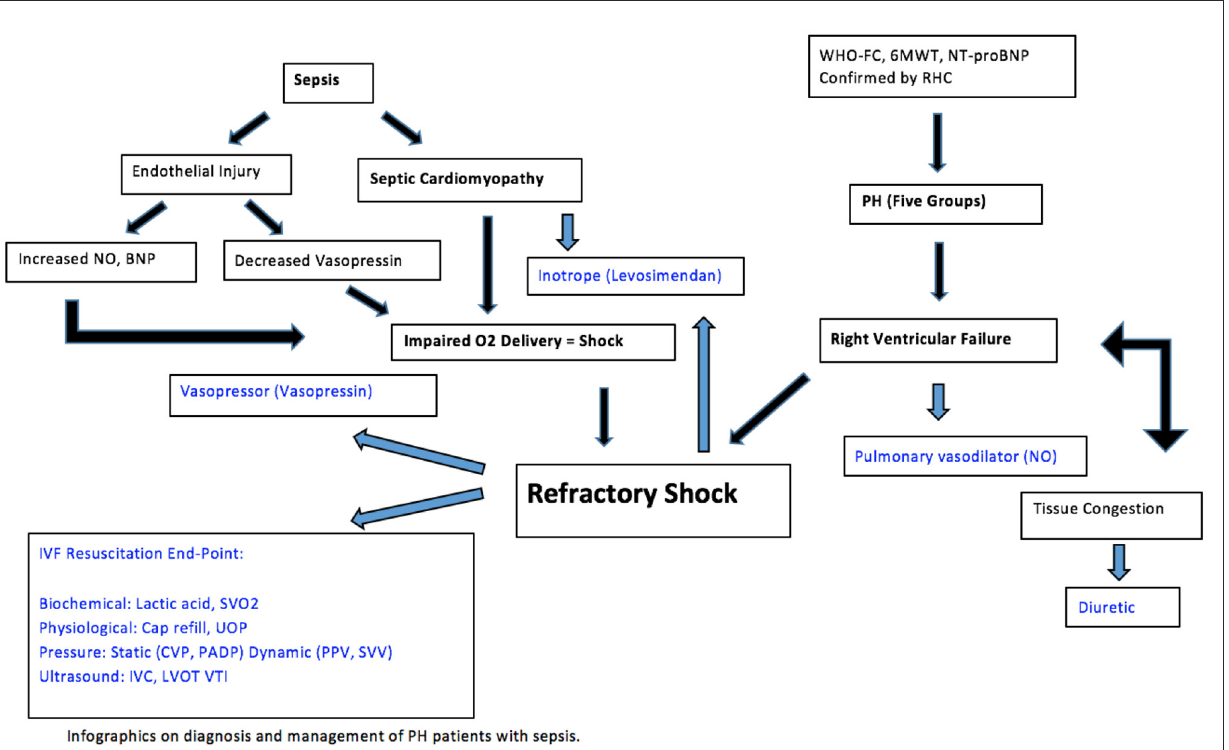
FIGURE3 Various pathological pictures and the appropriate therapeutic